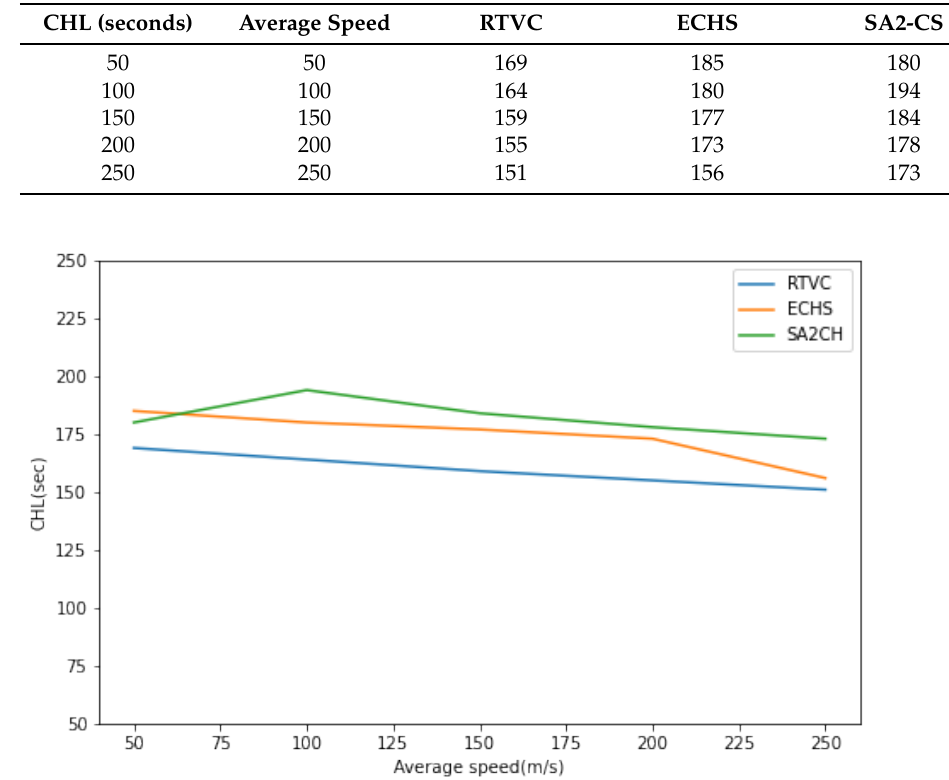
Table 2. Analysis of CHL.